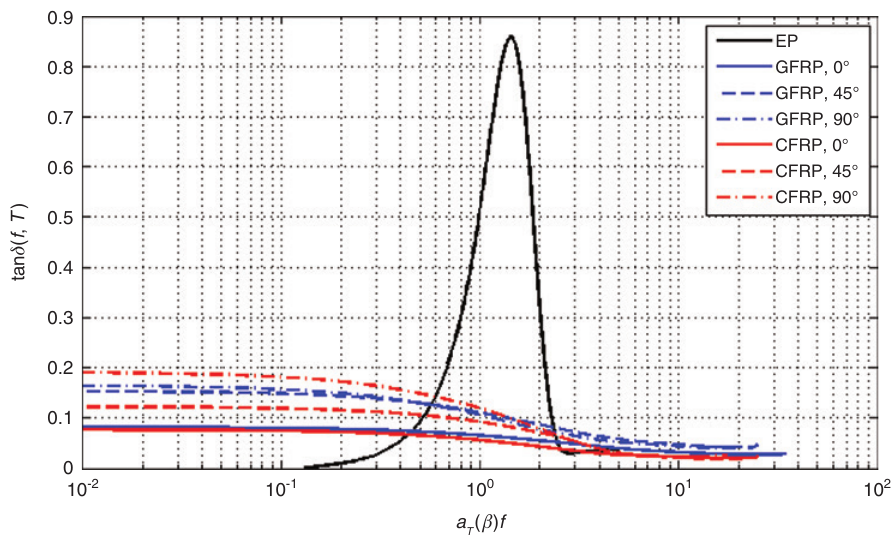
Figure 10: Master curves of the tangent loss factor for various materials and fibre